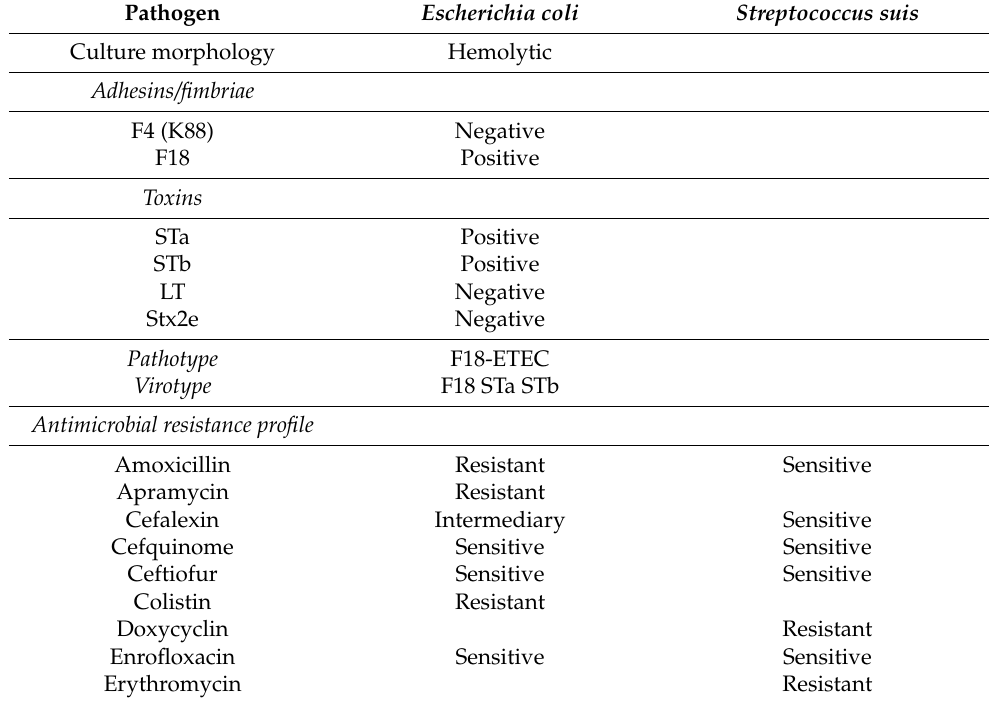
Table 1. Diagnostic laboratory results on isolation, identification, and antimicrobial resistance profile of the Escherichia coli strain involved in post-weaning diarrhea and the secondary clinical problem of acute mortality due to Streptococcus suis meningitis. Gray-colored blocks indicate the absence of relevant